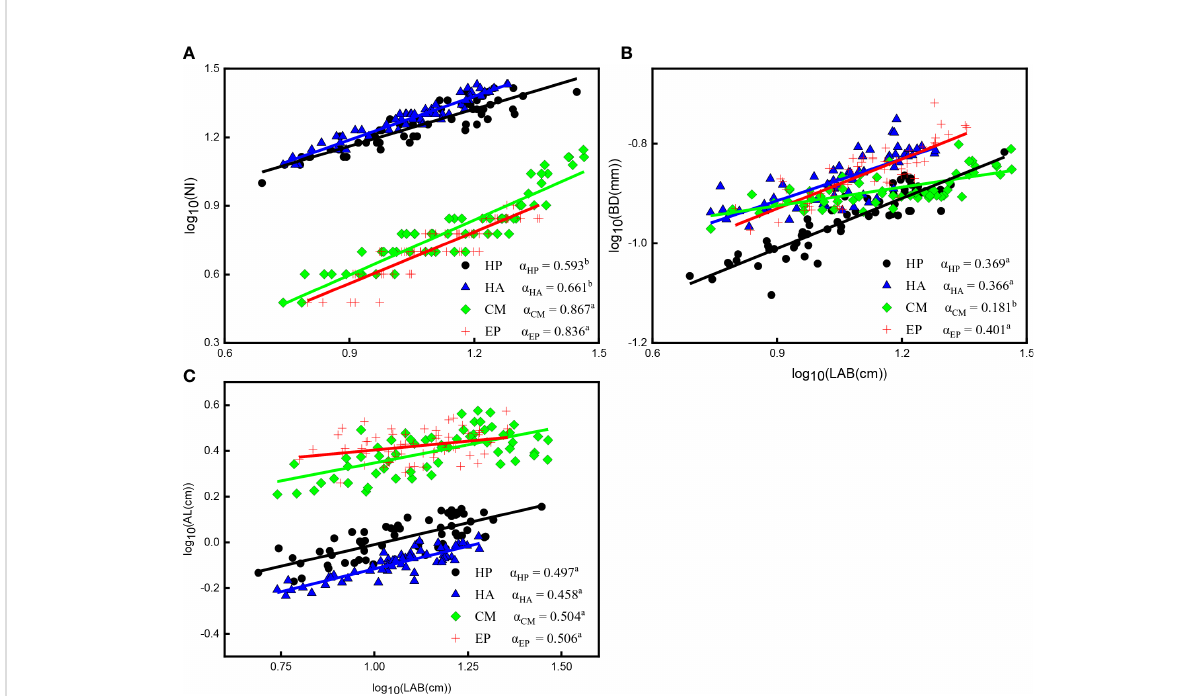
FIGURE 5 Allometric relationships among NI, BD, AL, and LAB of four desert shrubs. (A) The relationship between NI and LAB, (B) The relationship between BD and LAB, (C) The relationship between AL and LAB. Species: HP = Haloxylon persicum , HA = Haloxylon ammodendron , CM = Calligonum mongolicum , and EP = Ephedra przewalskii ; Functional traits: LAB = Length of assimilative branches, NI = Number of internodes, BD = Average basal diameter of assimilative branches, AL = Average length of the fi rst three internodes of assimilative branches; Different lowercase letters in the upper right-hand corner of the plot of scaling exponents ( a ) represent signi fi cant differences (P <